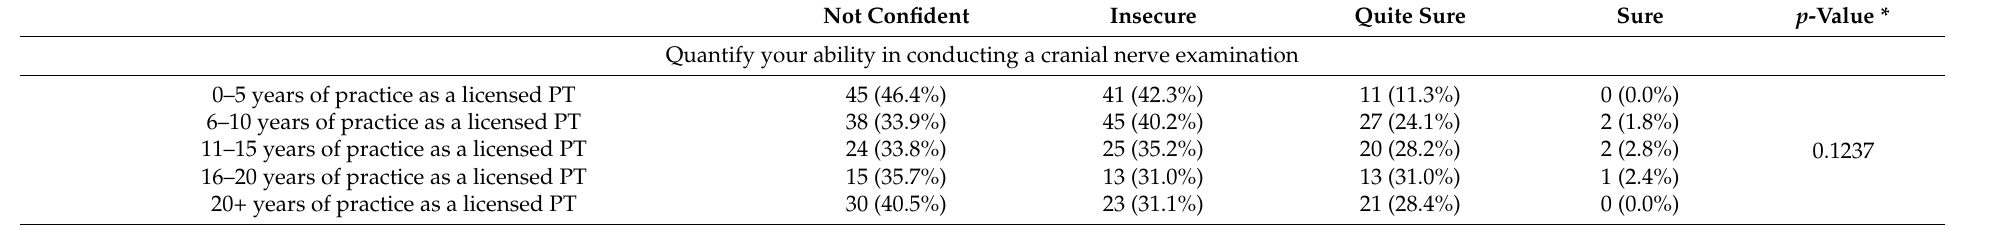
Table 4. Response to each survey questions, summarized for years’